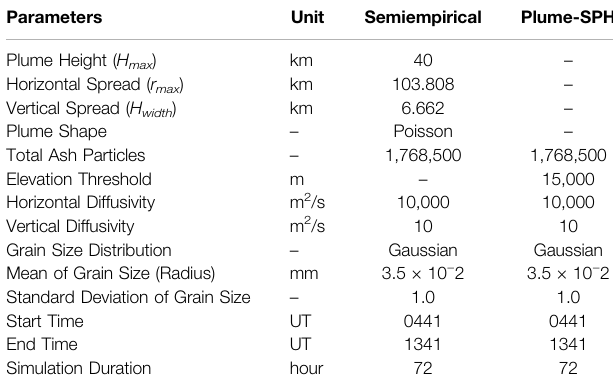
TABLE 2| Parametersused inVATDsimulation oftheclimacticphaseofPinatubo eruption onJune 15,1991. The fi rst sixparameters are used bysemiempirical expression to create an initial ash cloud. When creating an initial condition based on the Plume-SPH model, these parameters are extracted from output of Plume- SPH